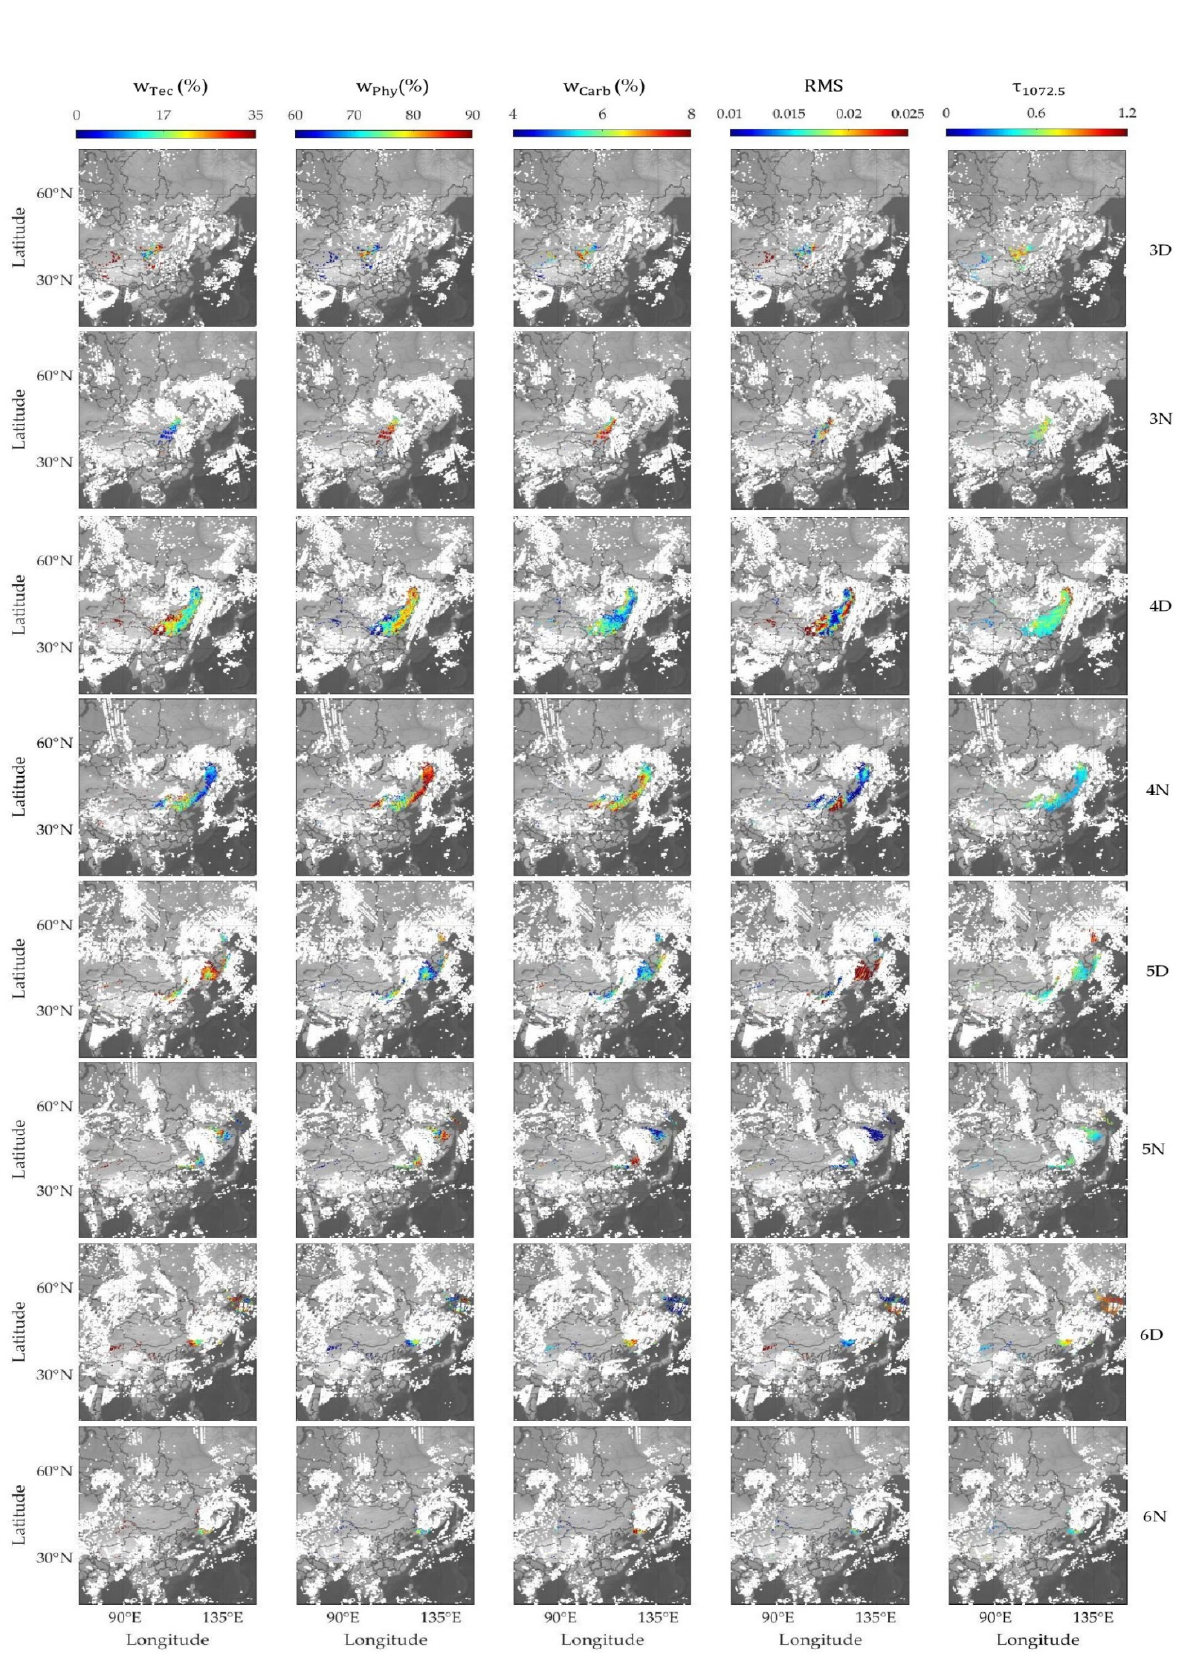
Figure 14. Mineralogical mass weight maps of tectosilicates, phyllosilicates, and carbonates during the 3–6 May 2017 dust storm by day (D) and night (N) from IASI detections.